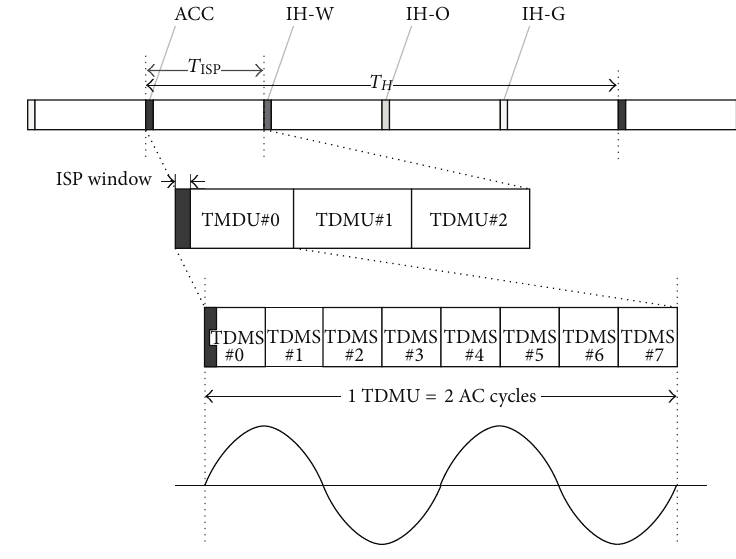
Figure 23: Time Division Multiplexing on ISP.